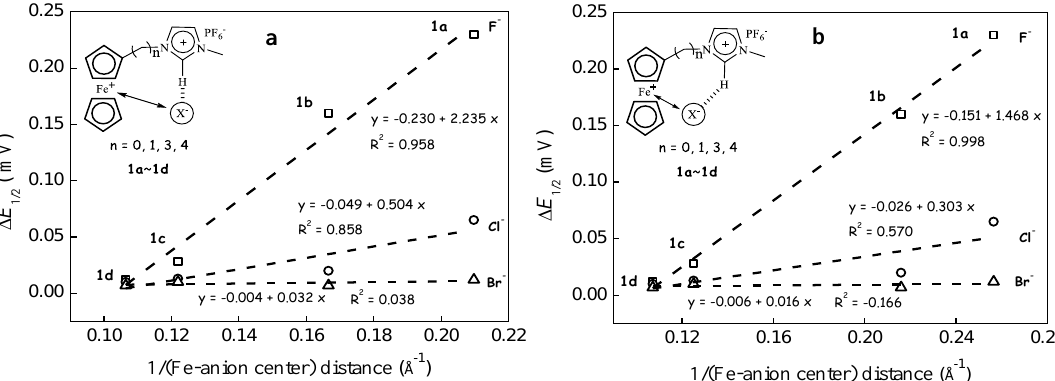
Figure 6. Complexation-induced potential shifts of 1a – 1d as a function of the inverse Fe–anion center distances when ( a ) neglecting and ( b ) considering the intramolecular anion transfer process.